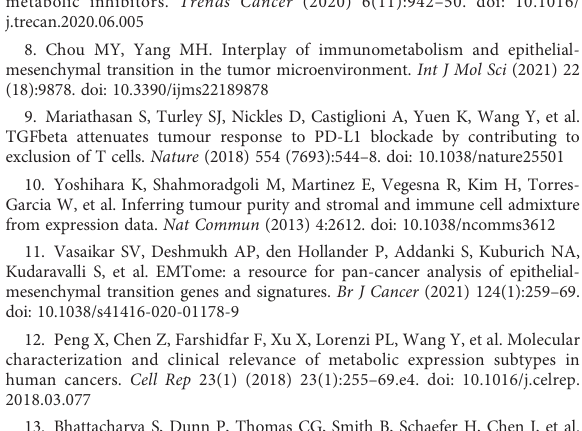
SUPPLEMENTARY FIGURE 1 The prognostic value of various EMT signatures from numerous studies. The TCGA cohort is the validation cohort. SUPPLEMENTARY FIGURE 2 Correlation between the 14 signature genes and their correlation with metabolic